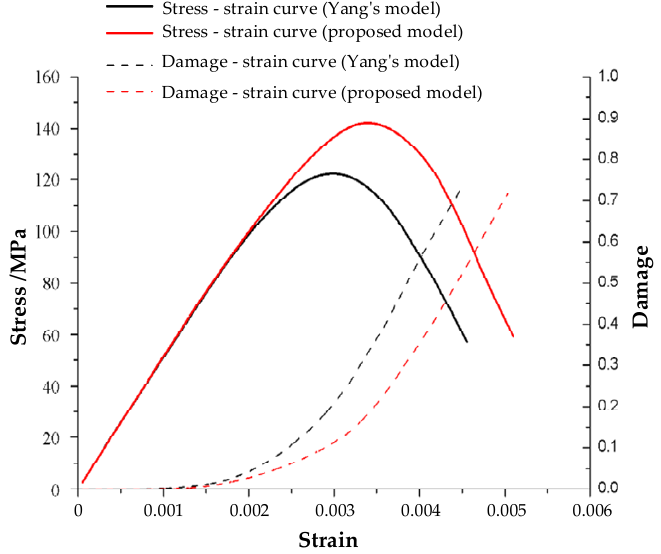
Figure 2. Stress-strain curve and damage-strain curve (strain rate = 100 s − 1 Figure 2. Stress ‐ strain curve and damage ‐ strain curve (strain rate = 100 s − 1 ).